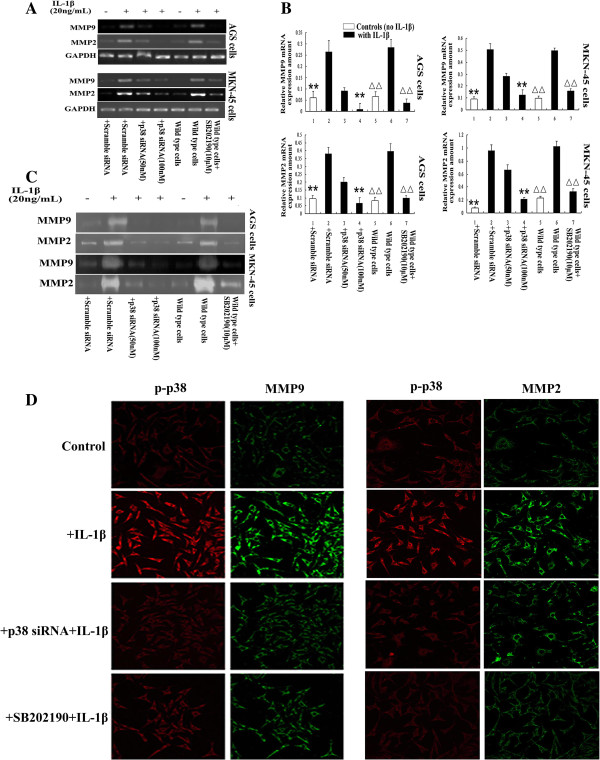
IL-1β upregulates MMP2 and MMP9 expression and activity by activating p38. A: RT-PCR analysis showed that MMP2 and MMP9 mRNA were upregulated in both AGS and MKN-45 cells in response to treatment with IL-1β; this effect was blocked by p38 siRNA or the p38 inhibitor SB202190. B: Quantification of the expression of MMP2 and MMP9 mRNA normalized to GAPDH mRNA. **P < 0.05 vs. scramble siRNA-transfected cells stimulated with IL-1β. △△P < 0.05 vs. untransfected cells stimulated with IL-1β. C: Gel zymography showed that MMP2 and MMP9 activity were upregulated in both AGS and MKN-45 cells in response to treatment with IL-1β; this effect was blocked by p38 siRNA or the p38 inhibitor SB202190. D: Immunocytochemical staining and confocal microscopy confirmed that IL-1β increased activation of p38 (red), and MMP2 and MMP9 (green) expression in MKN-45 GA cells; these effects were blocked by p38 siRNA or the p38 inhibitor SB202190.